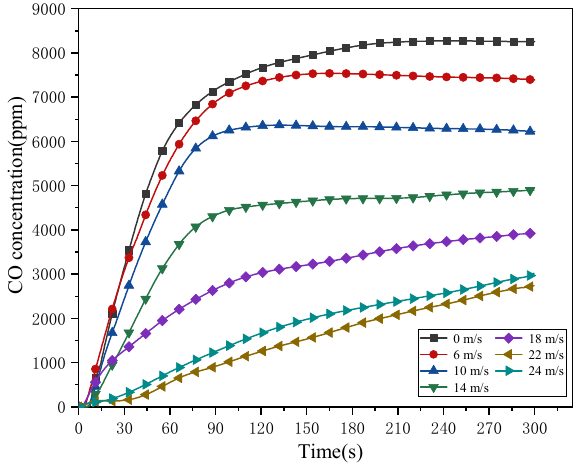
Figure 12. The CO concentration with air curtains installed on the top side.